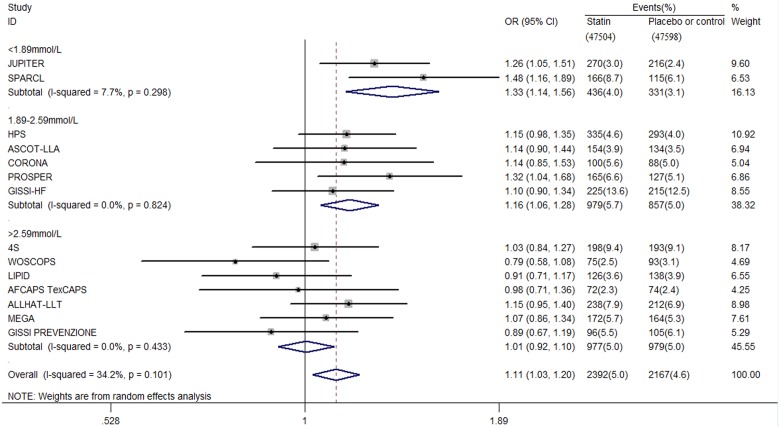
Association between different target LDL-c level and incident diabetes.